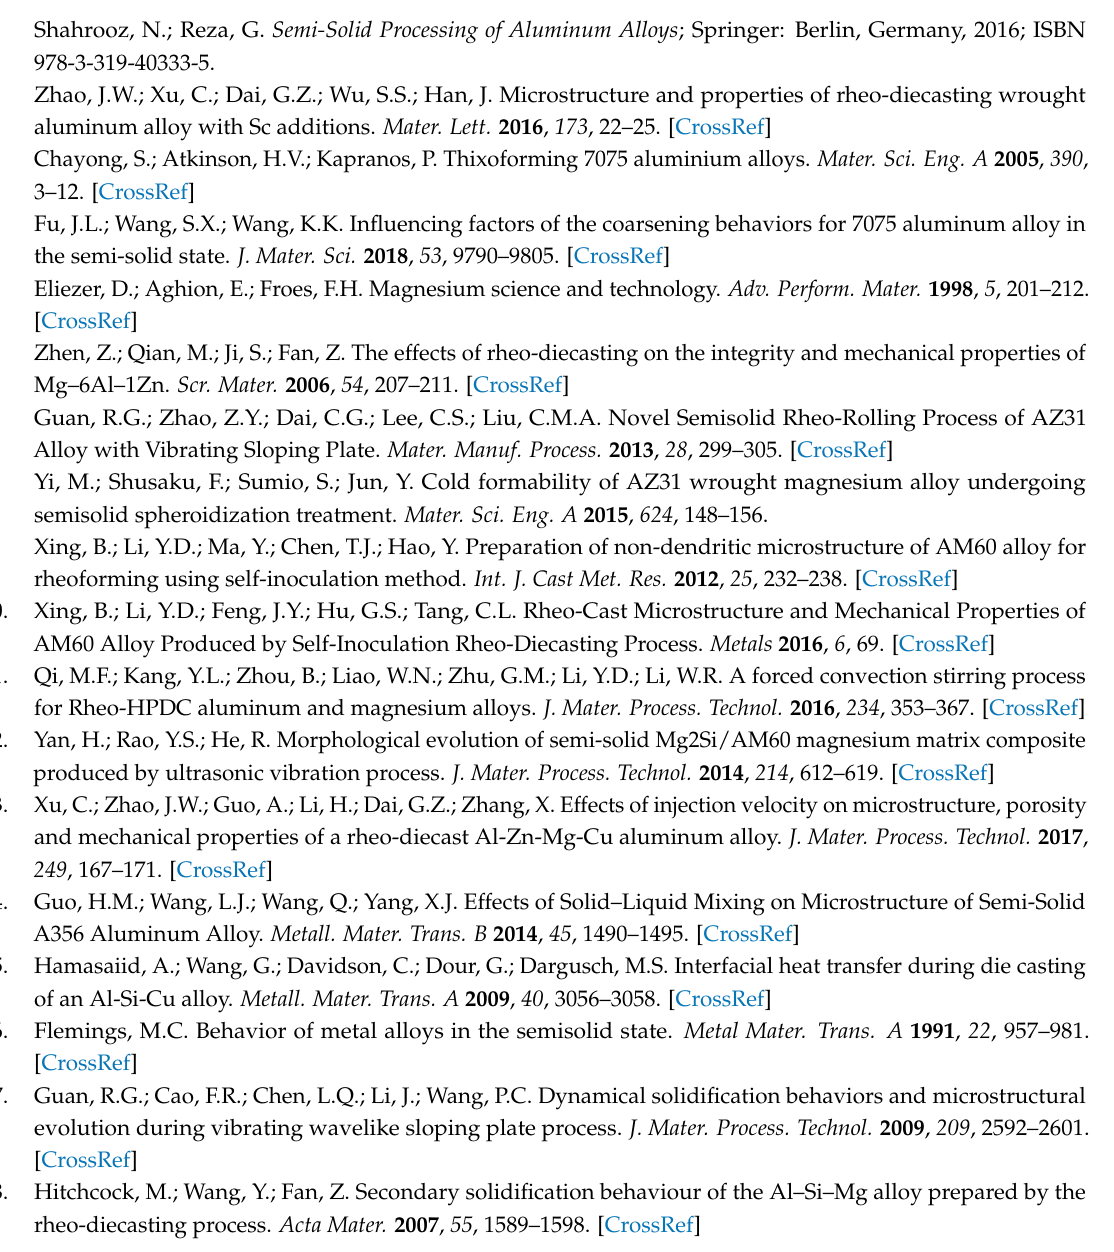
Tensile strength of the rheo-diecast AZ31 sample decreased with the increase of injection